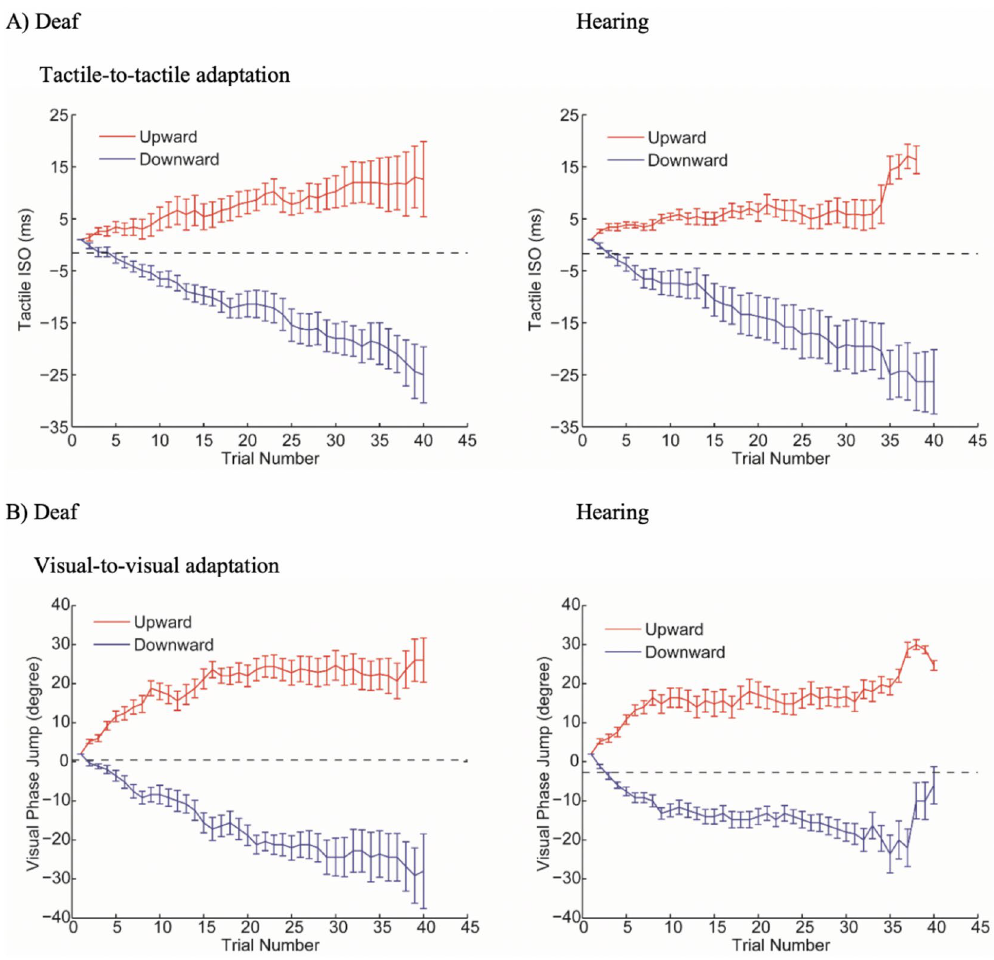
Figure 9. Staircase progress in Experiment 2. The staircase progress is shown separately for the deaf (left column) and hearing participants (right column) in the tactile-to-tactile (panel A ) and visual-to-visual (panel B ) adaptation conditions. Staircases in the upward and downward adaptation conditions are shown respectively in red and blue. The black dashed lines were the average baseline PSE without adaptation. Error bars represent one standard